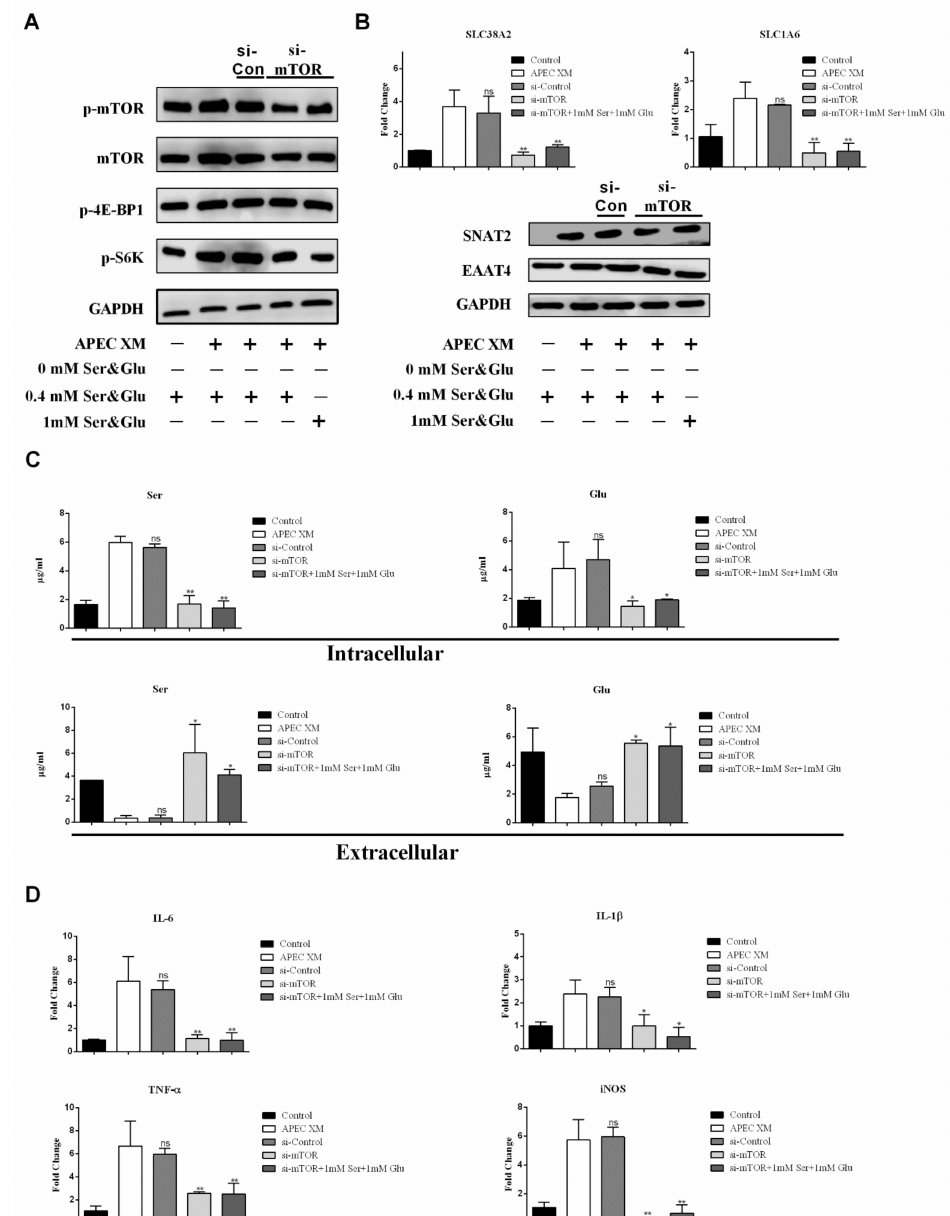
Figure 8. The effect of mTOR silencing on Ser or Glu uptake, expression of SNAT2 or